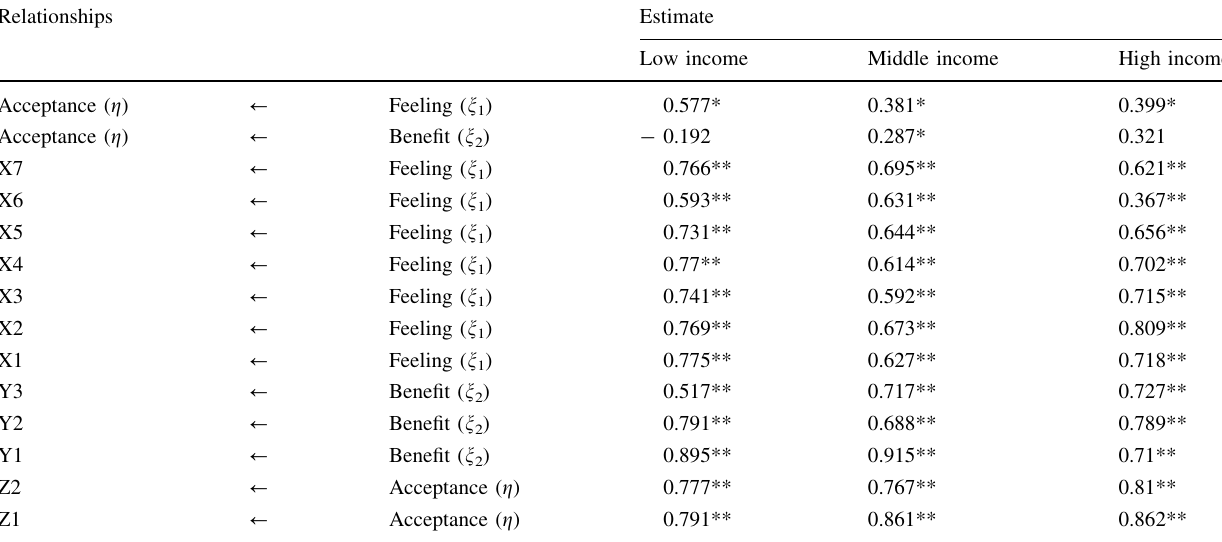
Table 6 Standardized regression estimates of measurement equations from SEM models